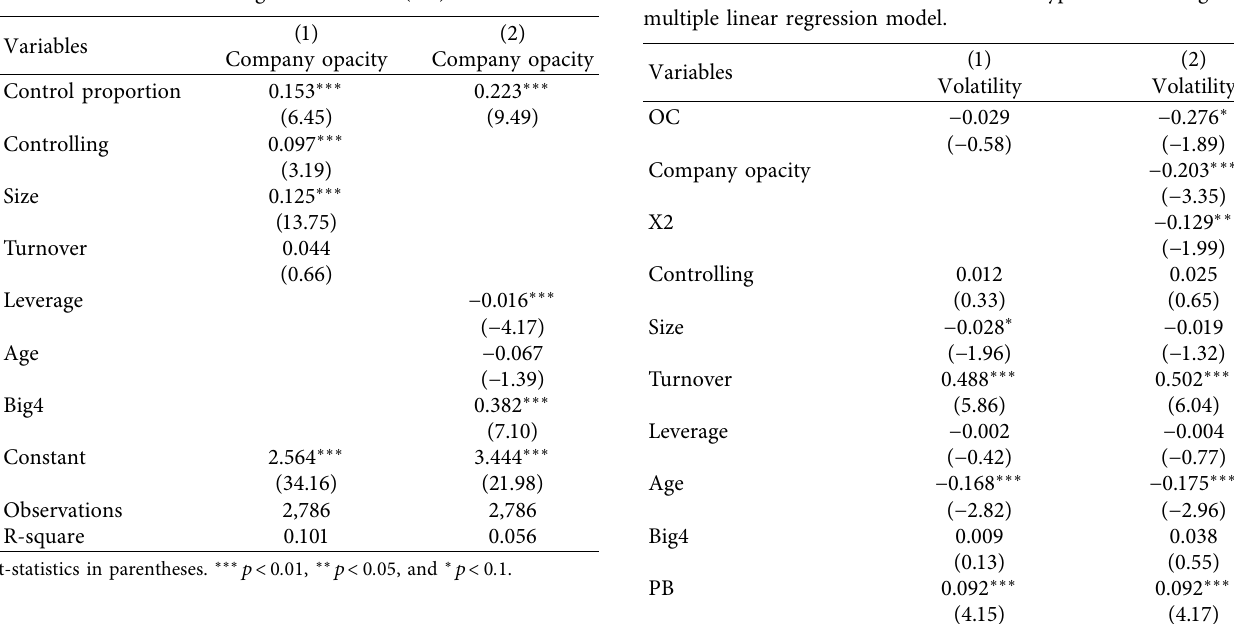
Table 4: Regression results (H1).